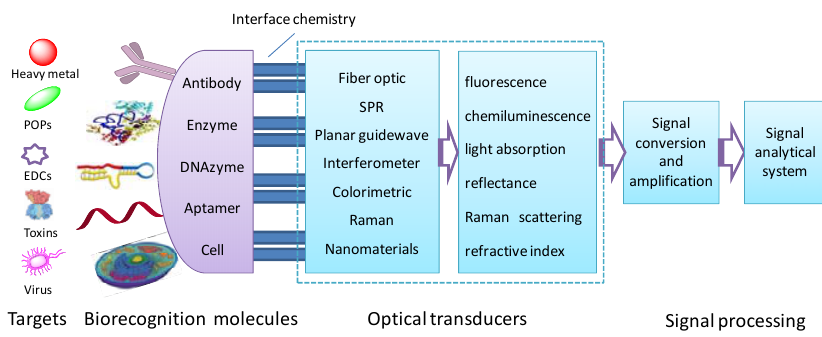
Figure 1. Schematic of an optical